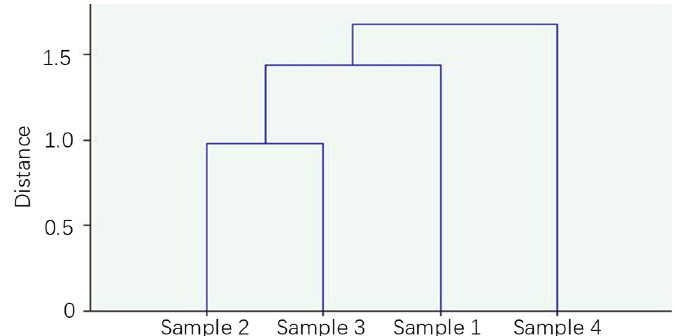
Figure 10. Results of clustering analysis carried out for the four sample events.